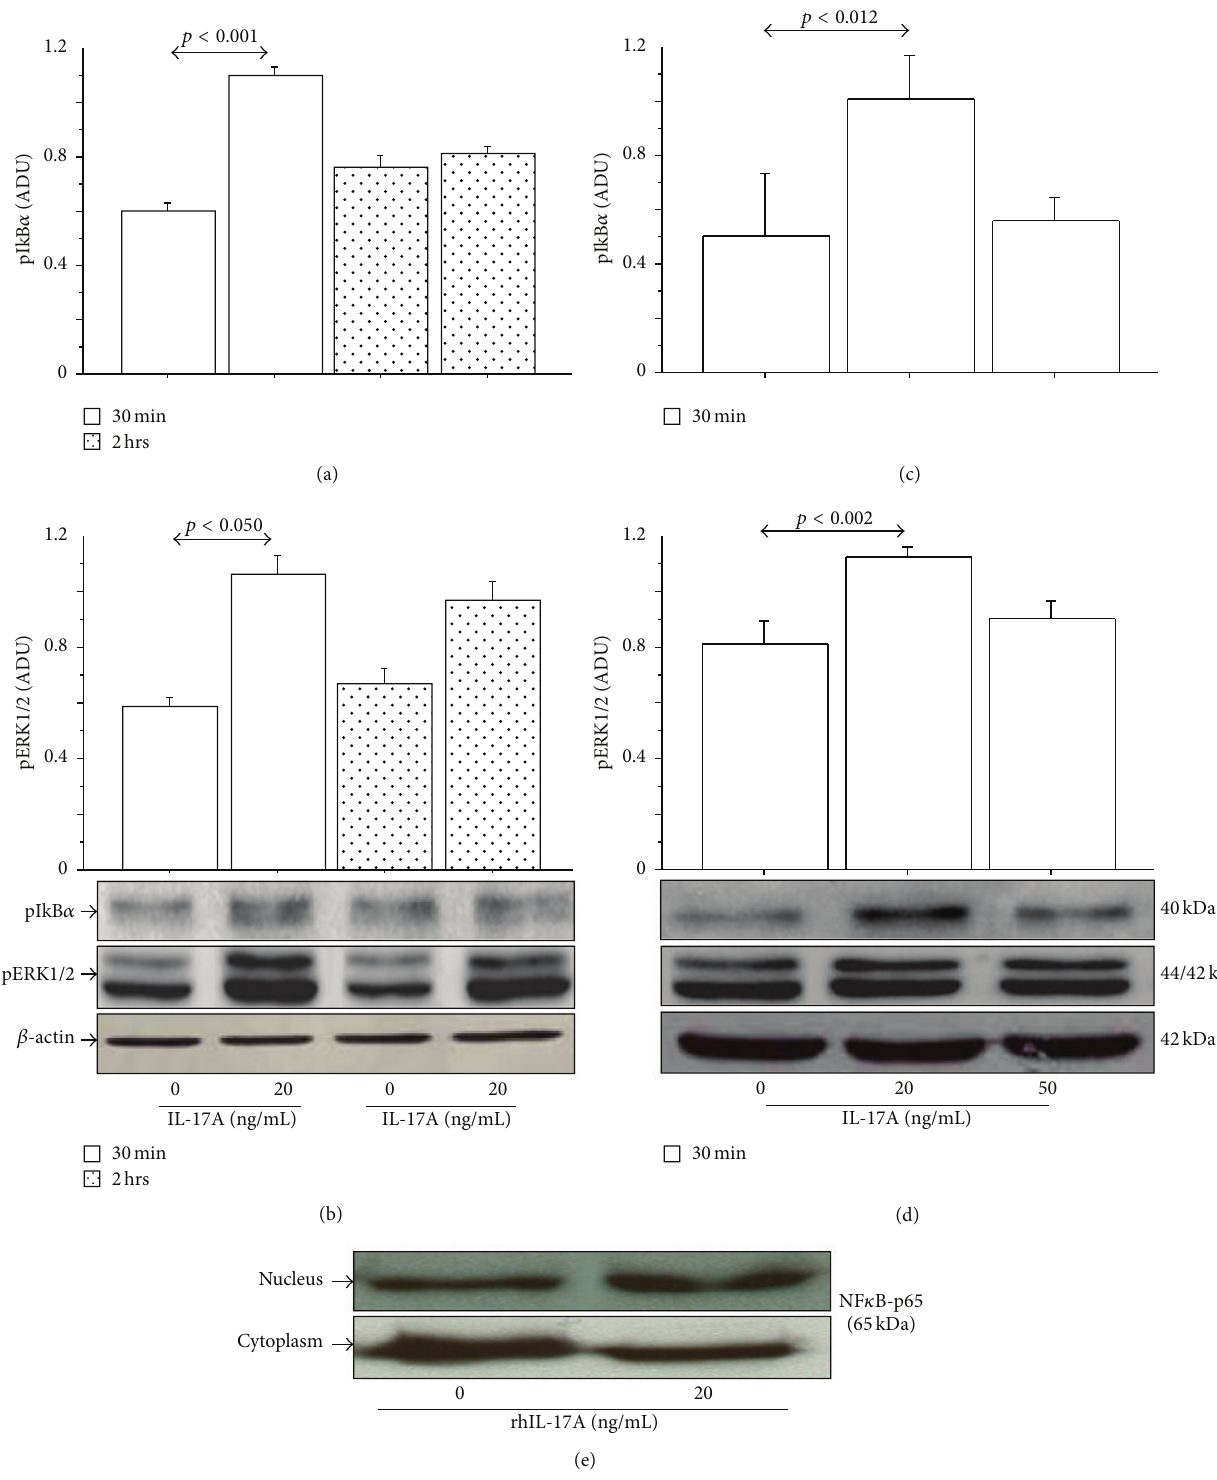
Figure 3: rhIL-17A increased pIkB 𝛼 and pERK1/2 in 16-HBE cells. Cells were stimulated with rhIL-17A (0–20ng/mL) for 30 min and 2 h to evaluate (a) pIkB 𝛼 and (b) pERK1/2 by western blot. Cells were stimulated with rhIL-17A (0–50 ng/mL) for 30min to evaluate (c) pIkB 𝛼 and (d) pERK1/2 by western blot. Bars represent the mean ± SD of arbitrary densitometric units (ADU) of three separate experiments. Representative western blot analyses of pIkB 𝛼 , pERK1/2 protein, and 𝛽 -actin are shown. (e) NF 𝜅 B-p65 subunit in nuclear and cytosol extracts from 16-HBE cells stimulated with rhIL-17A 20 ng/mL. Western blot analysis is shown. Statistical analysis was performed by Student’s 𝑡 -test and by ANOVA test followed by Fisher’s PLSD multiple comparison